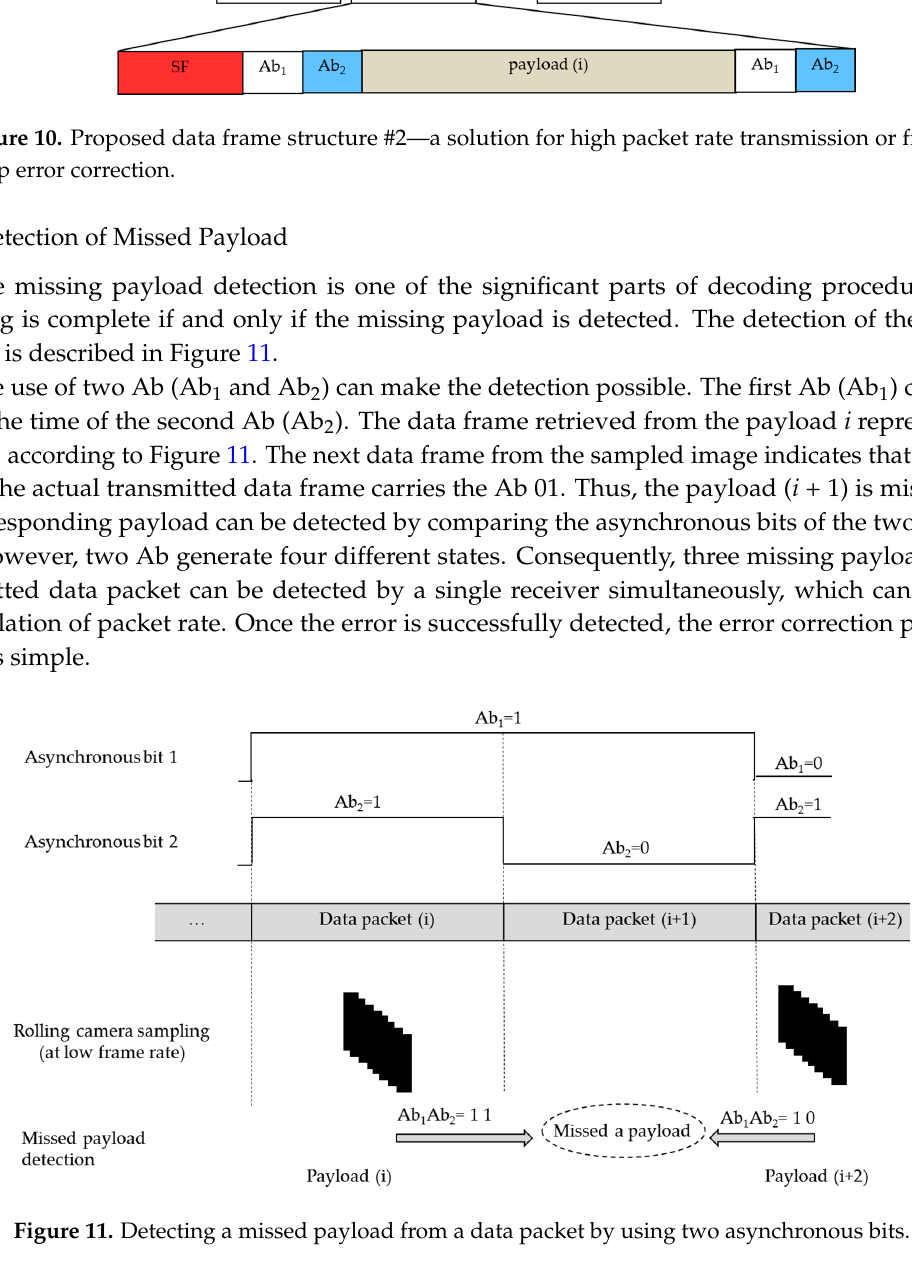
Figure 11. Detecting a missed payload from a data packet by using two asynchronous bits.